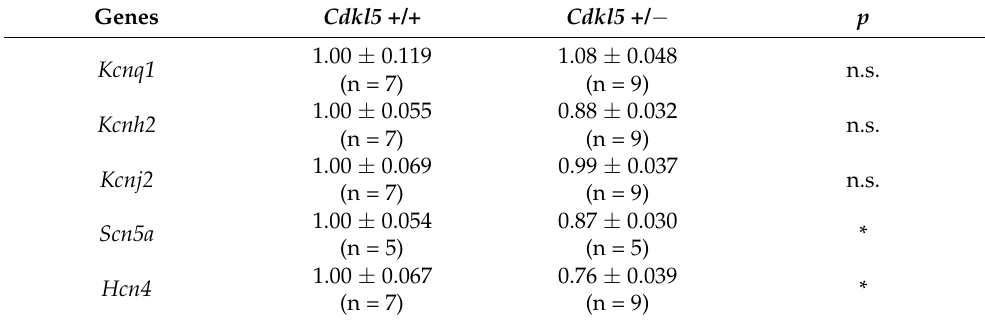
Table 2. Comparative expression of ion channel cardiac genes between Cdkl5 +/+ and Cdkl5 +/ − mice. mRNA expression levels of ion channel genes in the ventricle of 3-month-old Cdkl5 +/+ and Cdkl5 +/ − mice. mRNA levels in tissues obtained from Cdkl5 +/+ mice were set to 1, and relative expression levels in Cdkl5 +/ − mice are represented as mean ± SEM. Relative quantification was performed using the ∆∆ Ct method. The means of two stable reference genes ( Actin and Gapdh ) were used as normalization factors. * p < 0.05; n.s., not significant (two-tailed Student’s t -test).